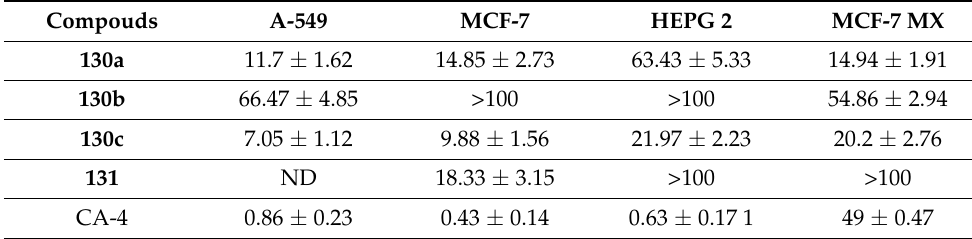
Table 7. The in vitro antiproliferative activities IC 50 ( µ M) of compounds 130a – 130c